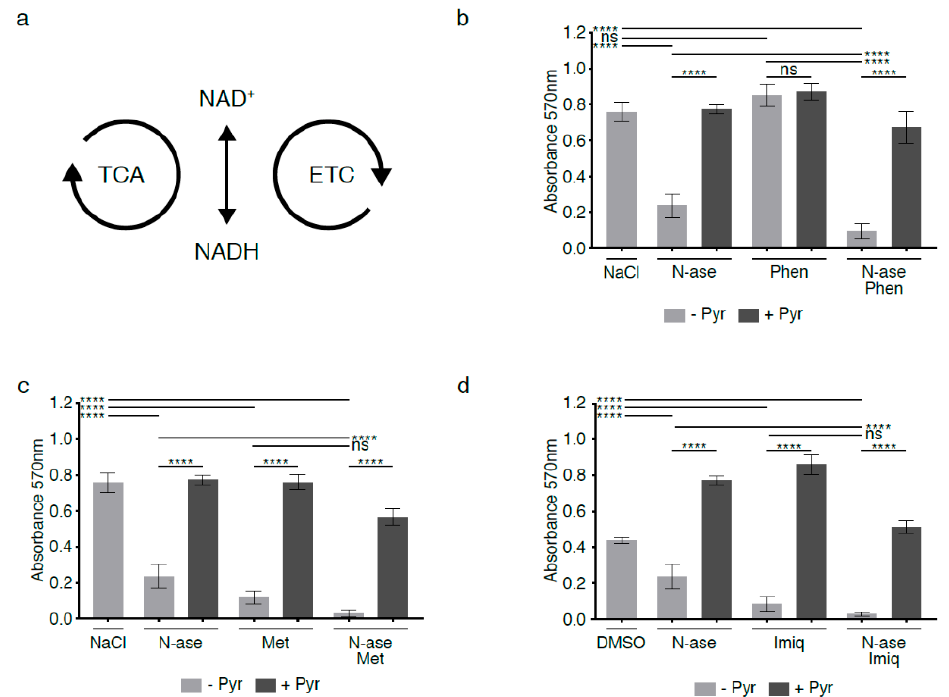
Figure 6. Synergistic growth-inhibitory effects of complex 1 inhibitors and asparaginase on mouse sarcoma cells. ( a ) Flux through the tricarboxylic acid cycle (TCA) and electron transport chain (ETC) is associated with a continuous flow of electrons, during which NAD + serves as an electron carrier in continuous cycles of reduction to NADH (e.g., via the TCA cycle) and oxidation back to NAD + (e.g., via the electron transport chain (ETC)). ( b ) Mouse sarcoma cells were exposed to low concentrations of the complex 1 inhibitor phenformin, which did not reduce sarcoma cell proliferation. However, combinatorial exposure to phenformin and asparaginase augmented the growth-inhibitory effects of asparaginase alone. Supplementation with the exogenous electron acceptor pyruvate reversed the growth inhibitory effects of phenformin and asparaginase, alone and in combination. ( c , d ) Two alternative complex 1 inhibitors (metformin and imiquimod) reduced mouse sarcoma cell proliferation and deepened the anti-proliferative effects of asparaginase. Again, the growth-inhibitory effects of asparaginase and metformin/imiquimod alone and in combination were reversed by supplementing cells with pyruvate. Chemicals were added using the following concentrations: phenformin 10 µ M, metformin 1 mM, imiquimod 20 µ M, asparaginase 0.3 U/mL and pyruvate 88.06 mg/L. Data were evaluated for statistical significance by one-way ANOVA with Tukey’s post-hoc test (ns p ≥ 0.05, **** p <